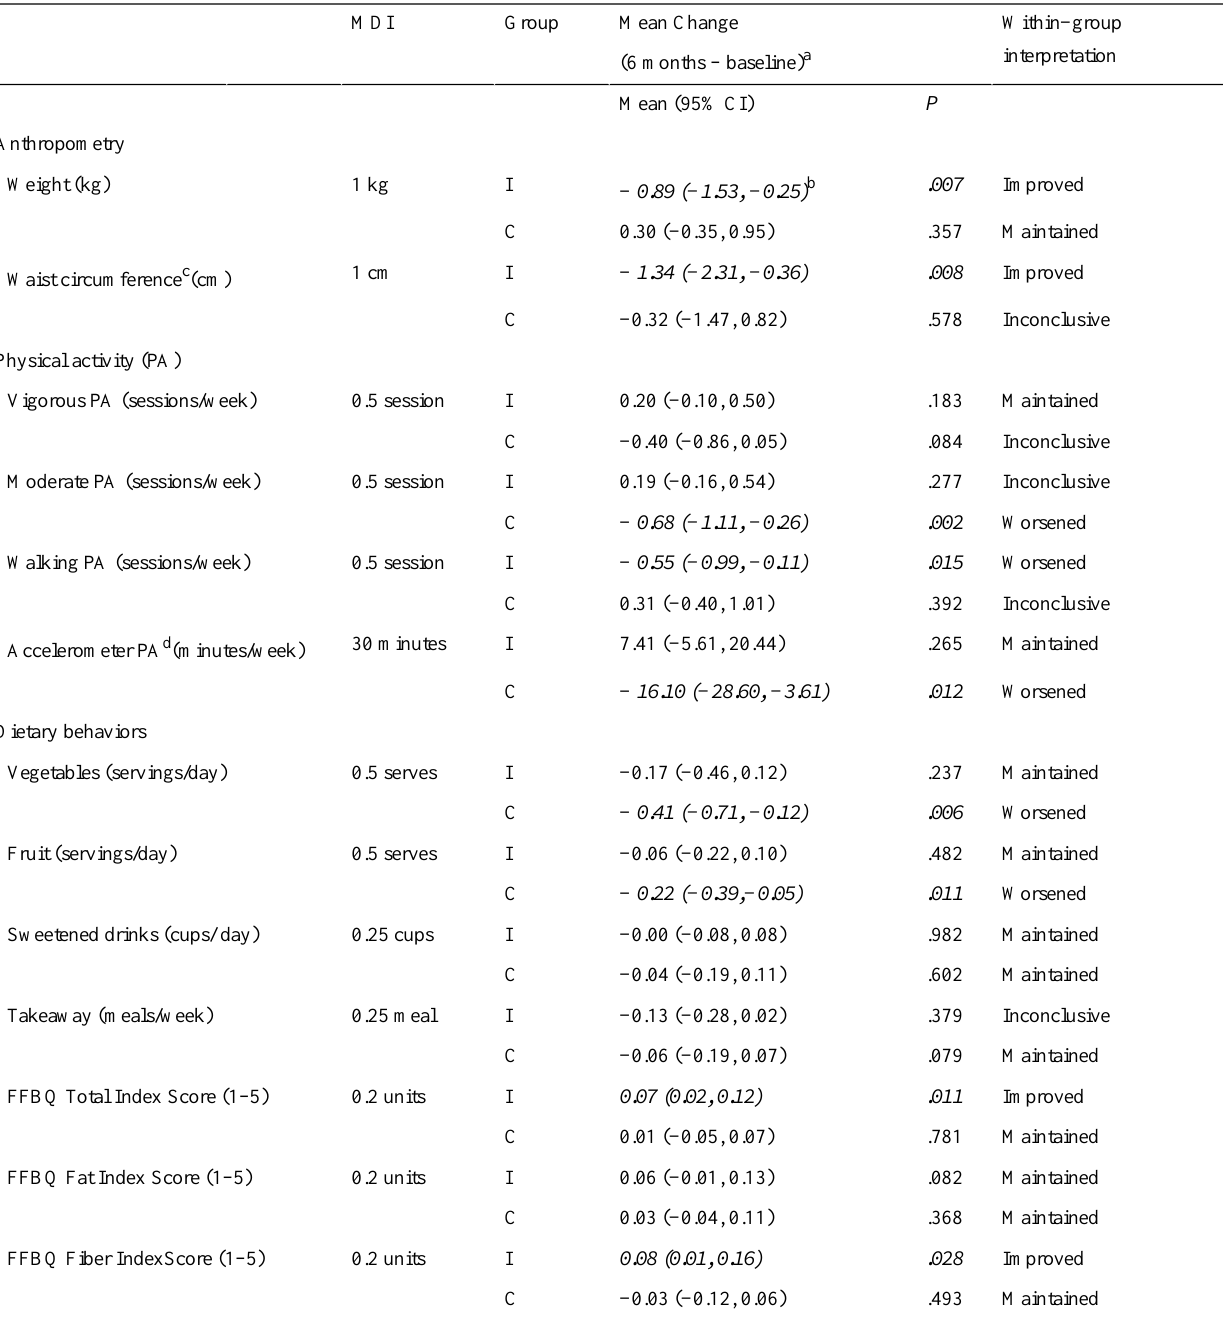
Table 2. Mean changes within the ‘Get Healthy, Stay Healthy’(GHSH) intervention group (I; n=104) and the control group (C; n=114)